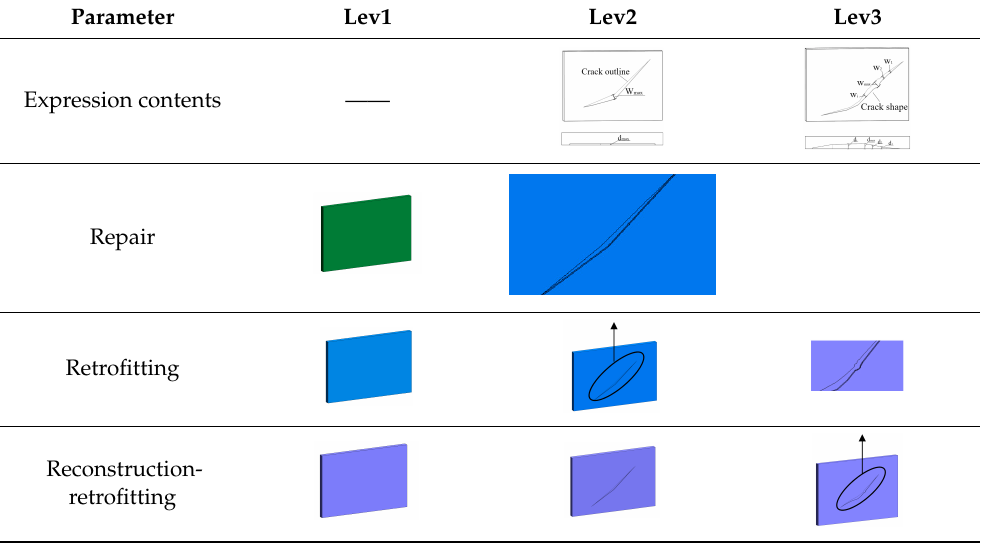
Table 1. Schematic diagram of multi-level expression of